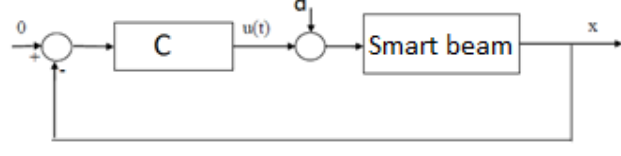
Fig. 1 Active vibration attenuation in a smart beam.